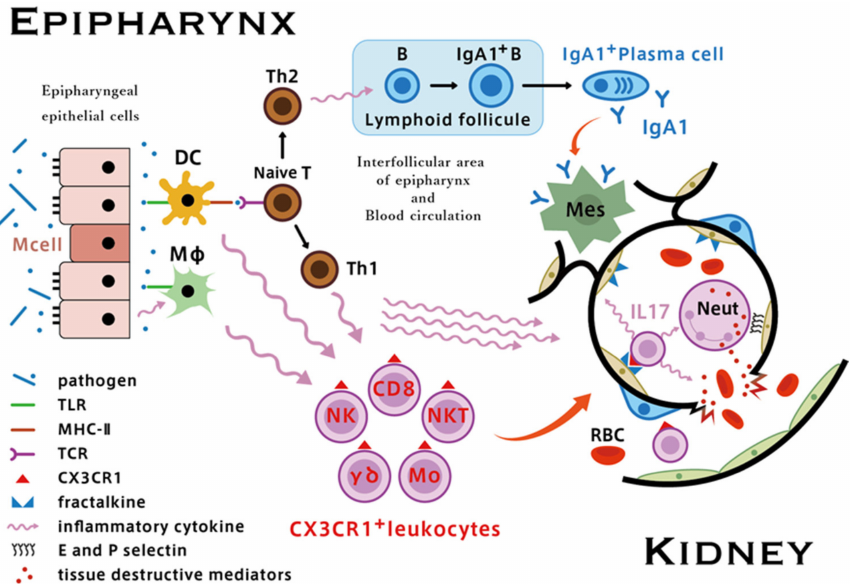
Figure 9. Putative mechanisms of the epipharynx–kidney axis causing glomerular vasculitis. In acute epipharyngitis, following pathogen recognition through TLRs, dendritic cells in the mucosa immediately produce proinflammatory cytokines. Simultaneously, infected epithelial cells and activated macrophages produce chemokines that upregulate the expression of CX3CR1 in monocytes, NK cells, CD8+ T cells, and γδ T cells. Circulating proinflammatory cytokines also enhance the expression of fractalkine and other adhesion molecules such as E- and P-selectins in glomerular endothelial cells. Upregulation of the fractalkine/CX3CR1 interaction and IL17 secreted by infiltrated glomerular CX3CR1+ leukocytes, which promotes the influx of neutrophils, leads to the development of Glomerular vasculitis and subsequent rupture of the glomerular capillary wall, which is clinically associated with worsening of hematuria